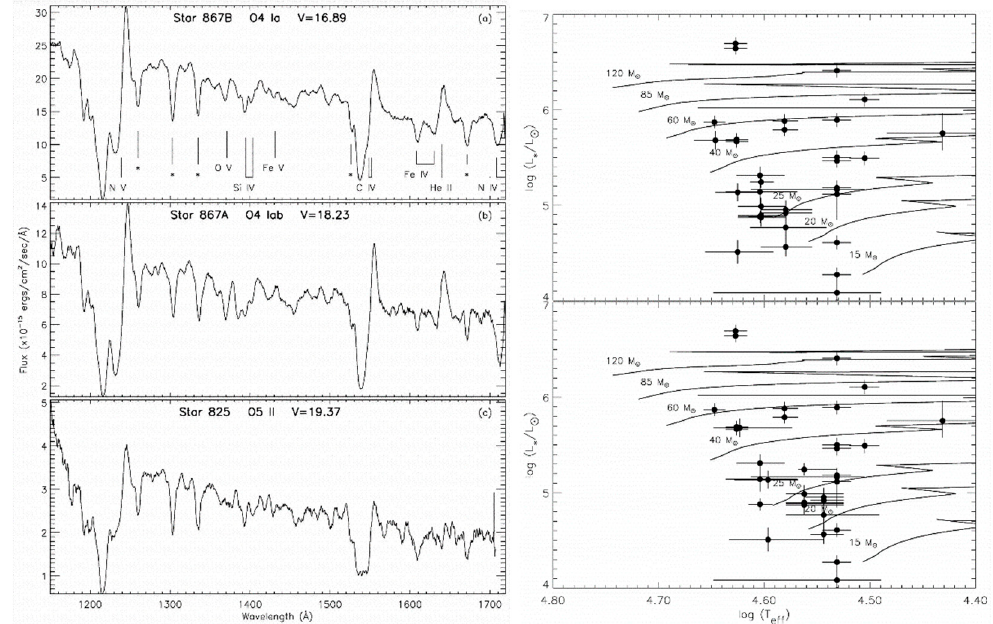
Figure 6. Left: examples of STIS / G140L UV spectra of the most luminous stars in NGC 604. Right: a Hertzsprung-Russell diagram of the most massive stars in NGC 604. The upper and lower figure are for two different calibrations of spectral type versus stellar parameters. From [22].